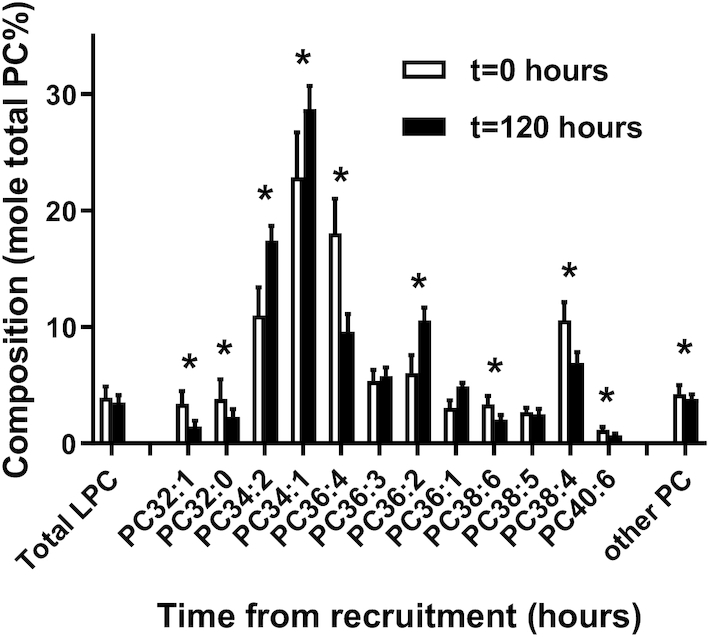
PC molecular species composition of preterm infant plasma. Results are presented at recruitment and expressed as a percentage of total PC (t = 0 h, n = 31, open bars) and at 5 d (t = 120 h, n = 23, closed bars). Values are means ± SDs. *P < 0.001 (t test). LPC, lysophosphatidylcholine; PC, phosphatidylcholine.